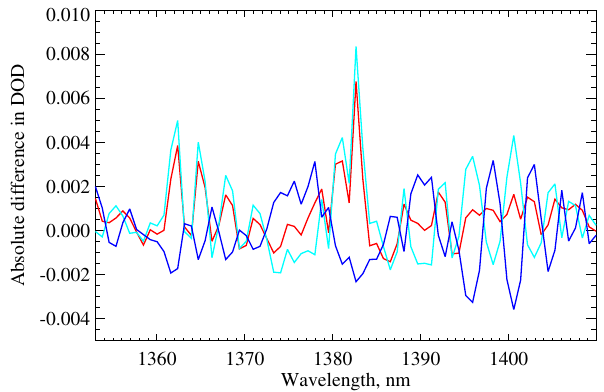
Fig. 5. Absolute differences in the differential optical depths (DOD) shown in Fig. 4 with respect to the standard scenario. The color coding is the same as in Figs. 3 and